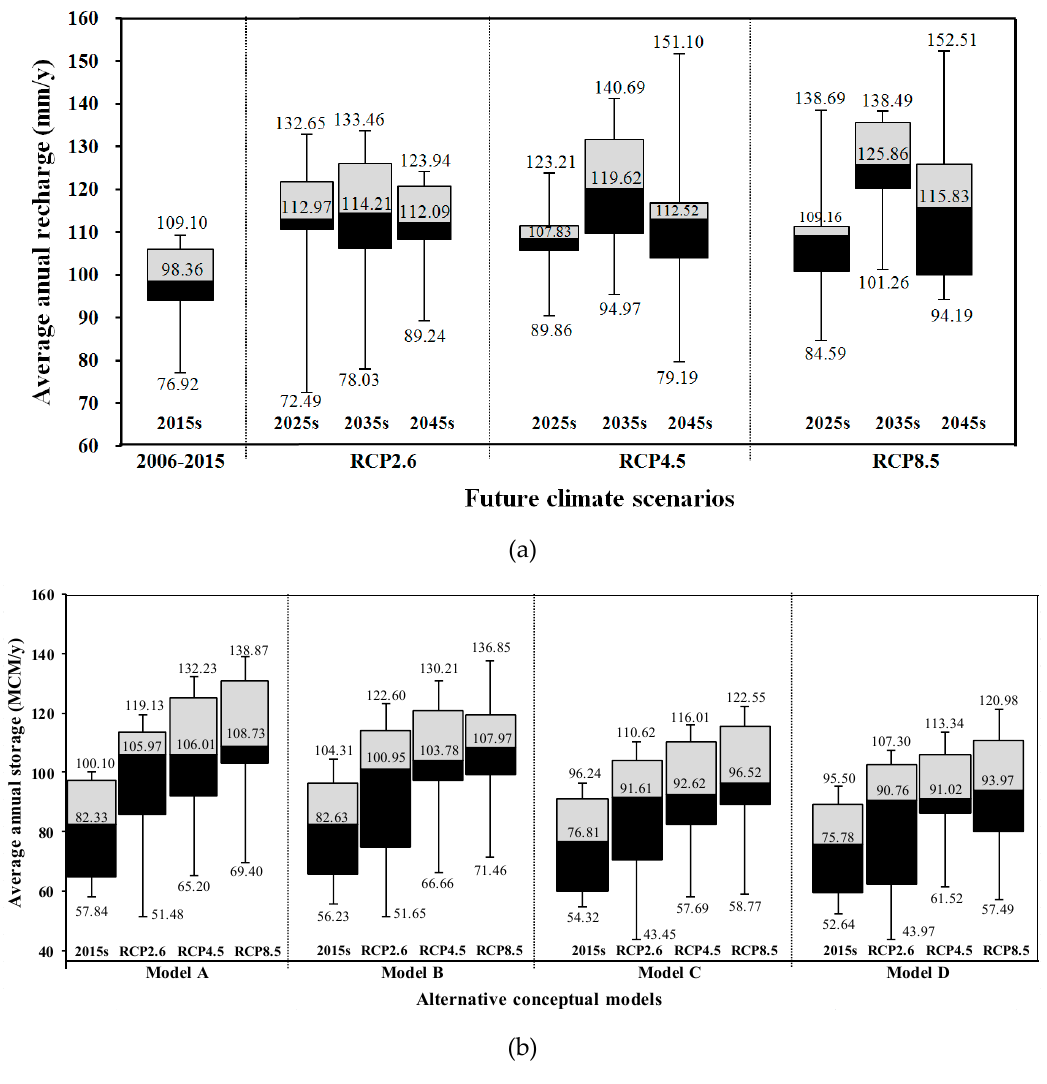
Figure 17. Simulation of future annual groundwater recharge ( a ) and simulations of future average annual aquifer storage of alternative conceptual models from 2016 to 2045 ( b ).